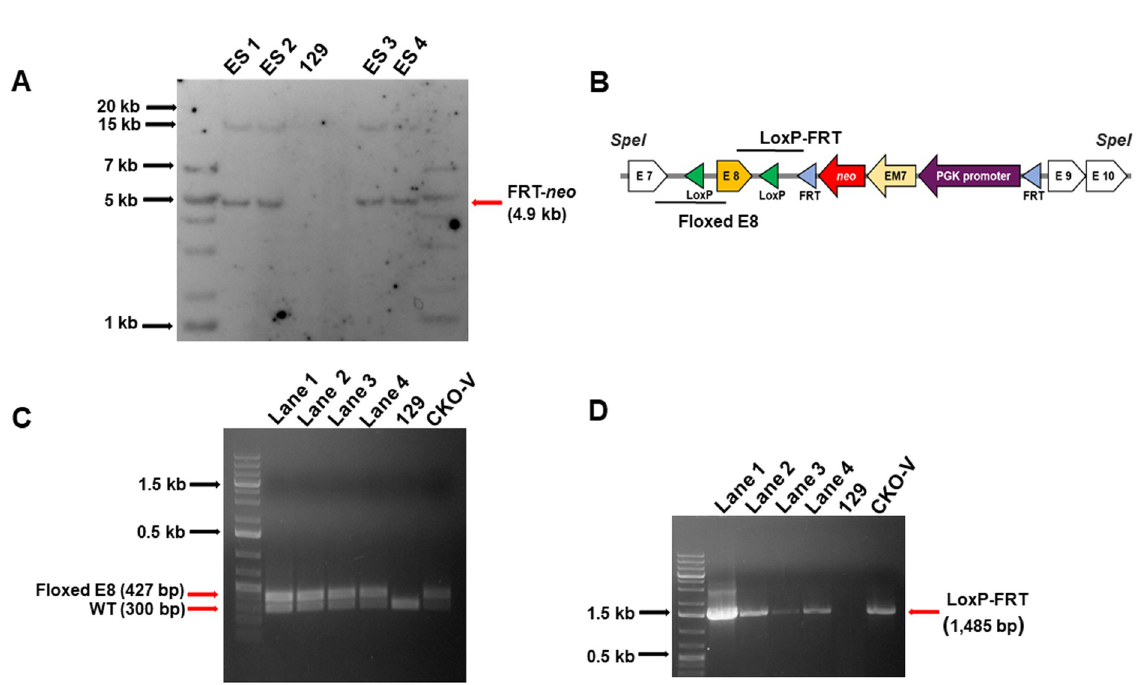
Fig 3. Genomic integration of the HLCS KO vector. (A) Southern blot analysis of ES cells. SpeI - and FRT- neo digested genomic DNA from transformed ES cells was probed with a 32 P-labeled oligonucleotide. (B) Schematic of the LoxP-FRT and Floxed E8 amplicons (underlined) in the HLCS KO plasmid used in genotyping. (C) Genotyping floxed E8 in genomic DNA from heterozygous HLCS KO pups (lanes 1–4). “129” denotes genomic DNA from mouse strain 129 (negative control); “CKO-V” denotes a mixture of HLCS KO vectors with and without LoxP sites (positive control). (D) LoxP-FRT sites were probed in genomic DNA. The samples are the same as those used in panel C, including negative and positive controls.